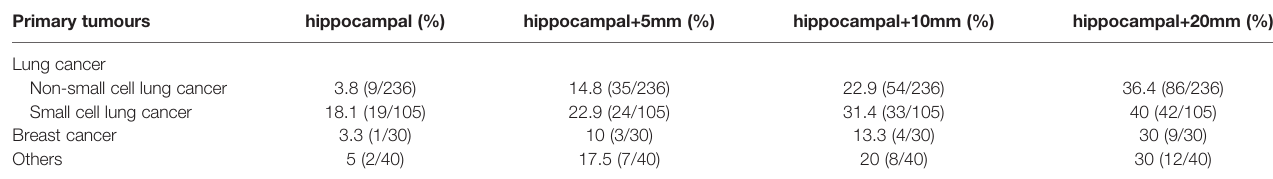
TABLE 3 | Metastasis rates of hippocampi and surrounding areas in different pathological types of